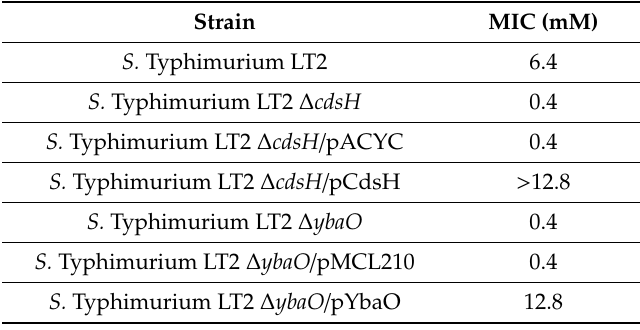
Table 3. MIC for cysteine in M9-glucose